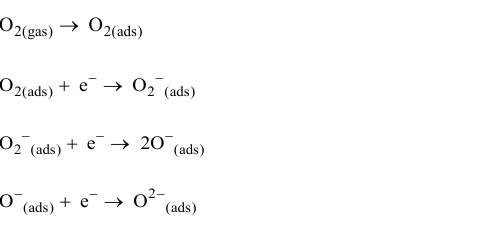
Figure 8. Response and recovery curve of WO optimum operating temperature (160 °C).